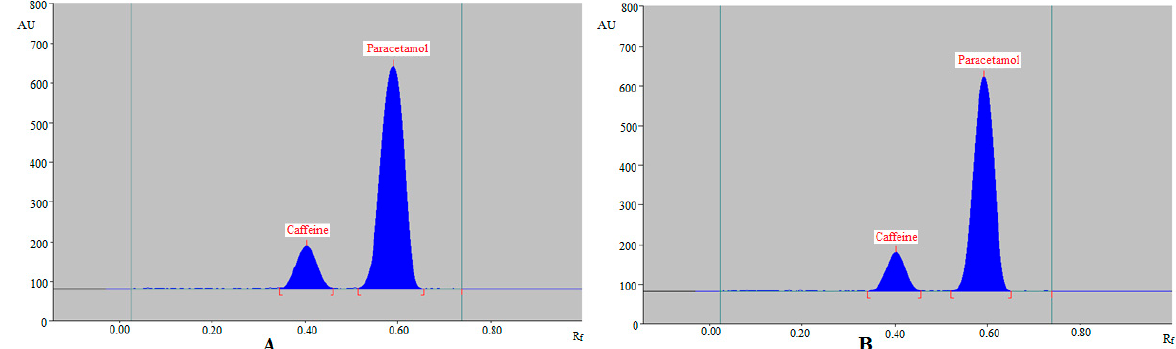
Figure 6. Normal ‐ phase HPTLC chromatograms of caffeine and paracetamol in ( A ) commercial tab ‐ Figure 6. Normal-phase HPTLC chromatograms of caffeine and paracetamol in ( A ) commercial lets PANEXT and ( B ) commercial tablets SAFEXT. tablets PANEXT and ( B ) commercial tablets SAFEXT.